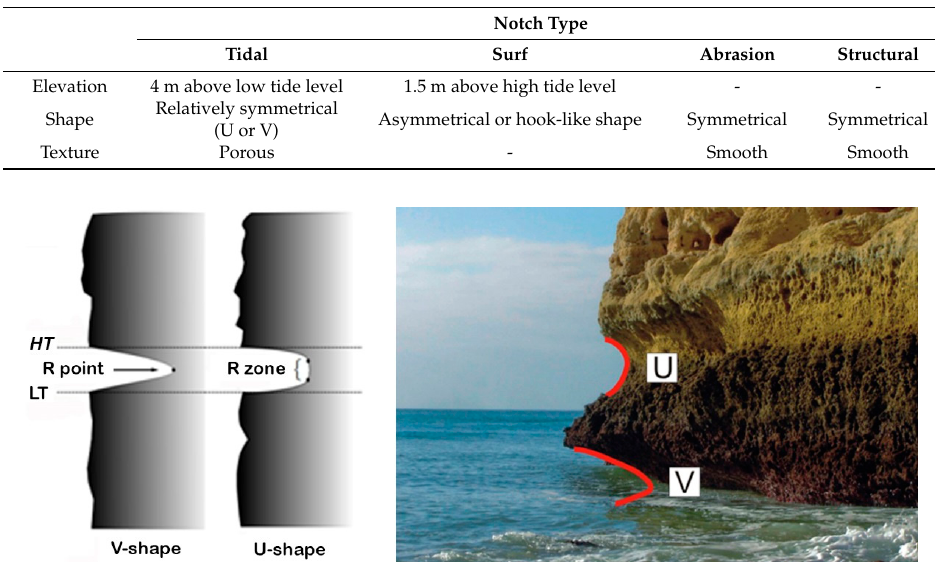
Figure 3. Sketch of U- and V-shape notches (adapted from [6]) with a field example (photo: P. Terefenko ). Notch identification on the cliff surface as well as further evaluation of notch shape was performed based on cliff hillshade and contour maps. Notches were located on cliff areas when two basic criteria were fulfilled. These criteria are detection of a sudden slope change as indicated by a dense isoline, and an observed high shade value of the hillshade raster. For this analysis, a shade color value of 180 was assigned as the threshold.